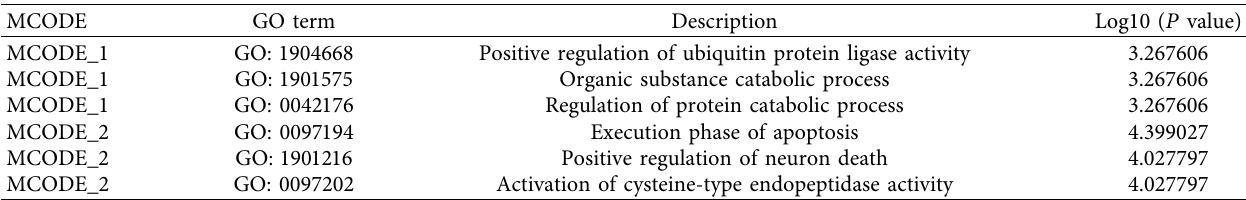
Figure 3: Module screening and functional analysis of the PPI network. (a) Protein-protein interaction network mapping the differentially expressed genes. (b) Module 1 generating from the PPI network. (c) Module 2 generating from the PPI network. (d) Shows fifteen hub genes with a high degree of connectivity. The red nodes represent upregulated DEGs, while the blue nodes represent downregulated DEGs. DEG: differential expression gene; PPI: protein-protein interaction. Table 2: Functional analysis of module 1 and module